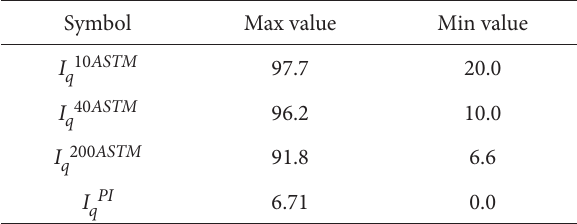
Table 8. Range of I q according to normalization procedure